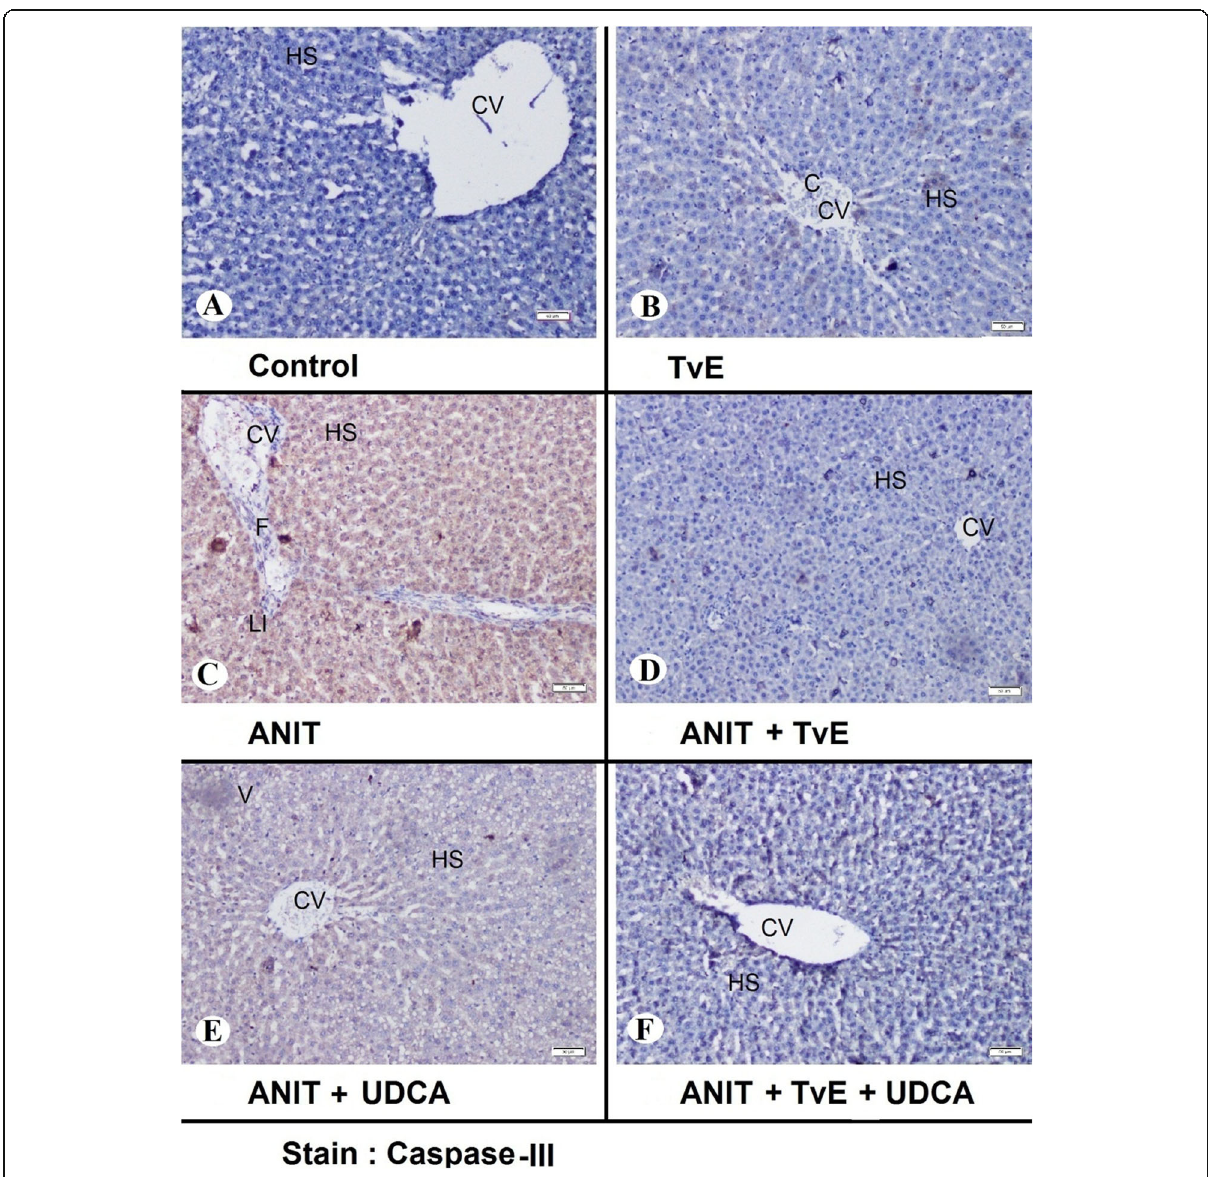
Fig. 4 Photomicrographs of hepatocytes of rats showing cellular distribution of immunoreactive caspase-3 protein as indicated by brown color. a Control group showing weak reaction. b (TvE) group showing weak reaction. c ANIT group showing strong positive reaction. d ANIT + TvE group showing weak reaction. e ANIT+UDCA group showing weak reaction. f ANIT + TvE + UDCA group showing weak reaction of caspase-3. Scale bar = 50 μ